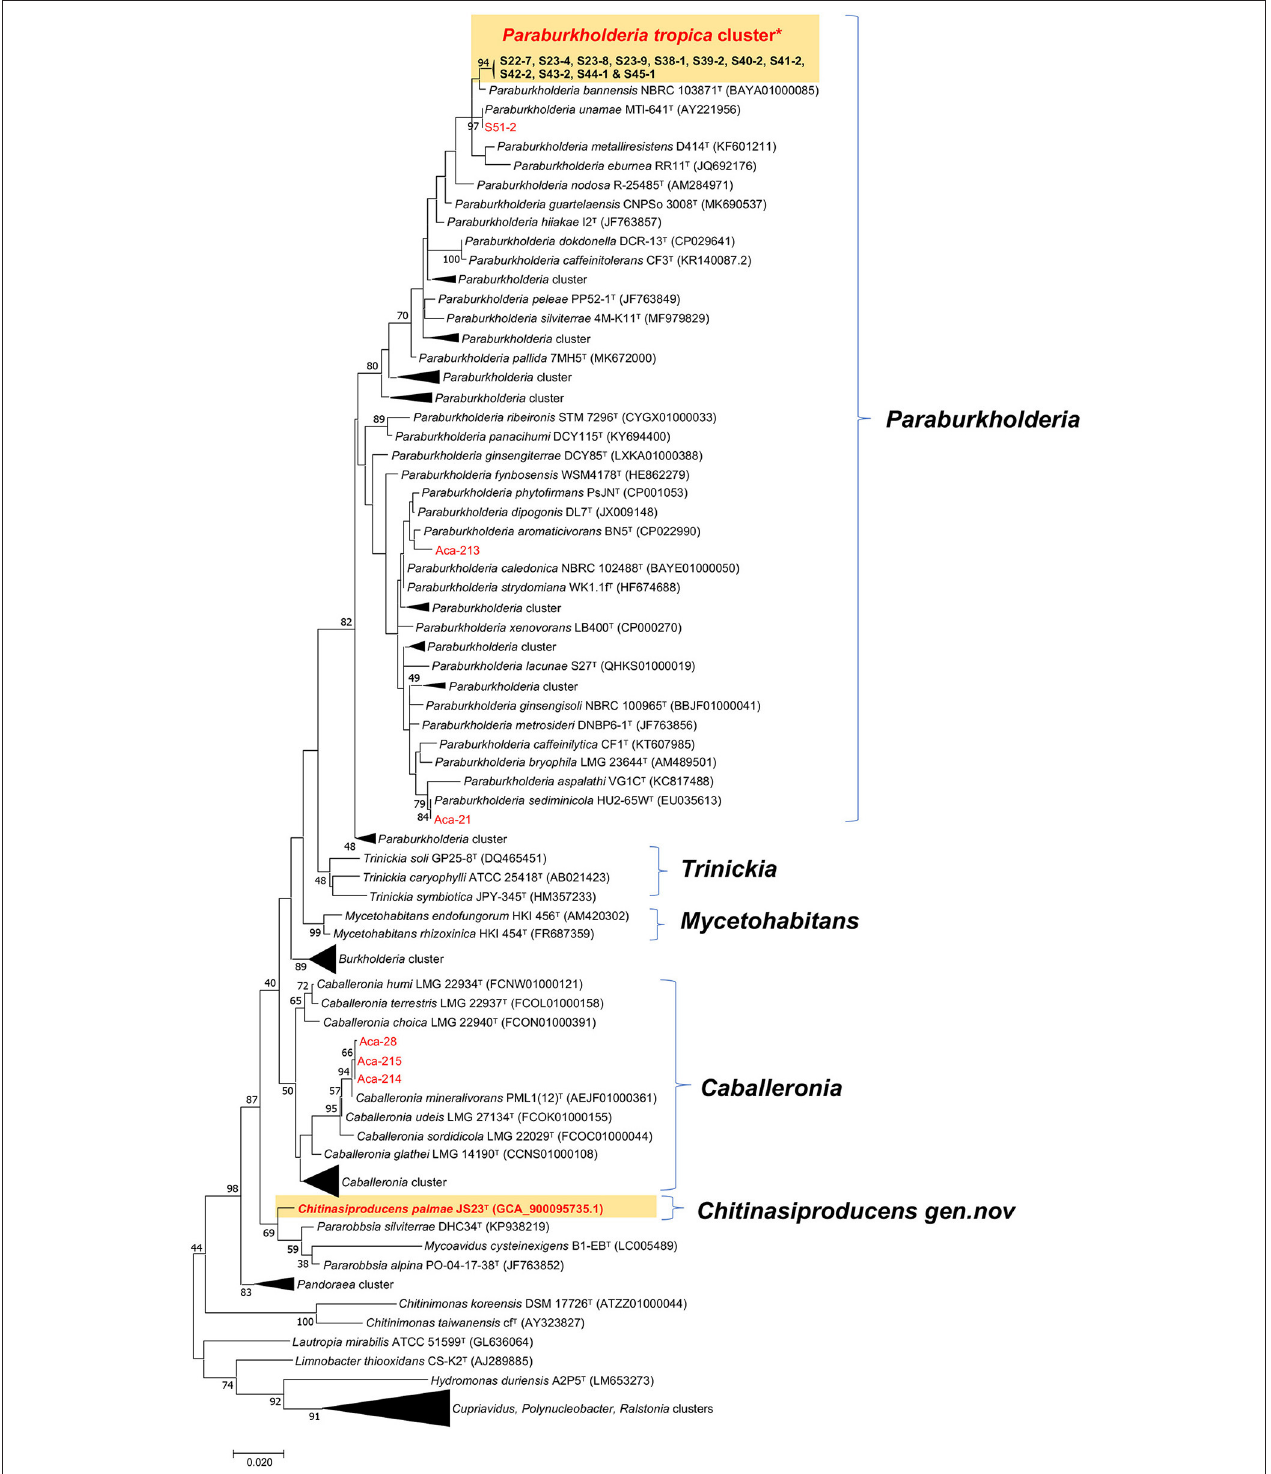
FIGURE 1 | Maximum-likelihood tree based on 16S rRNA gene sequences. Positions of isolates from tree crops and close relatives of the genera Caballeronia , Chitinasiproducens , and Paraburkholderia (family Burkholderiaceae ) are shown. GenBank accession numbers are given in parentheses. Bootstrap values (expressed as percentages of 500 replications) greater than 40% are shown at the branch points. Bar, 0.005 substitutions per nucleotide position. * Twelve strains (S22-7, S23-4, S23-9, S23-8, S38-1, S39-2, S40-2, S41-2, S42-2, S43-2, S44-1, and S45-1) closely related to P. tropica cluster and all isolated strains in the present study are indicated in